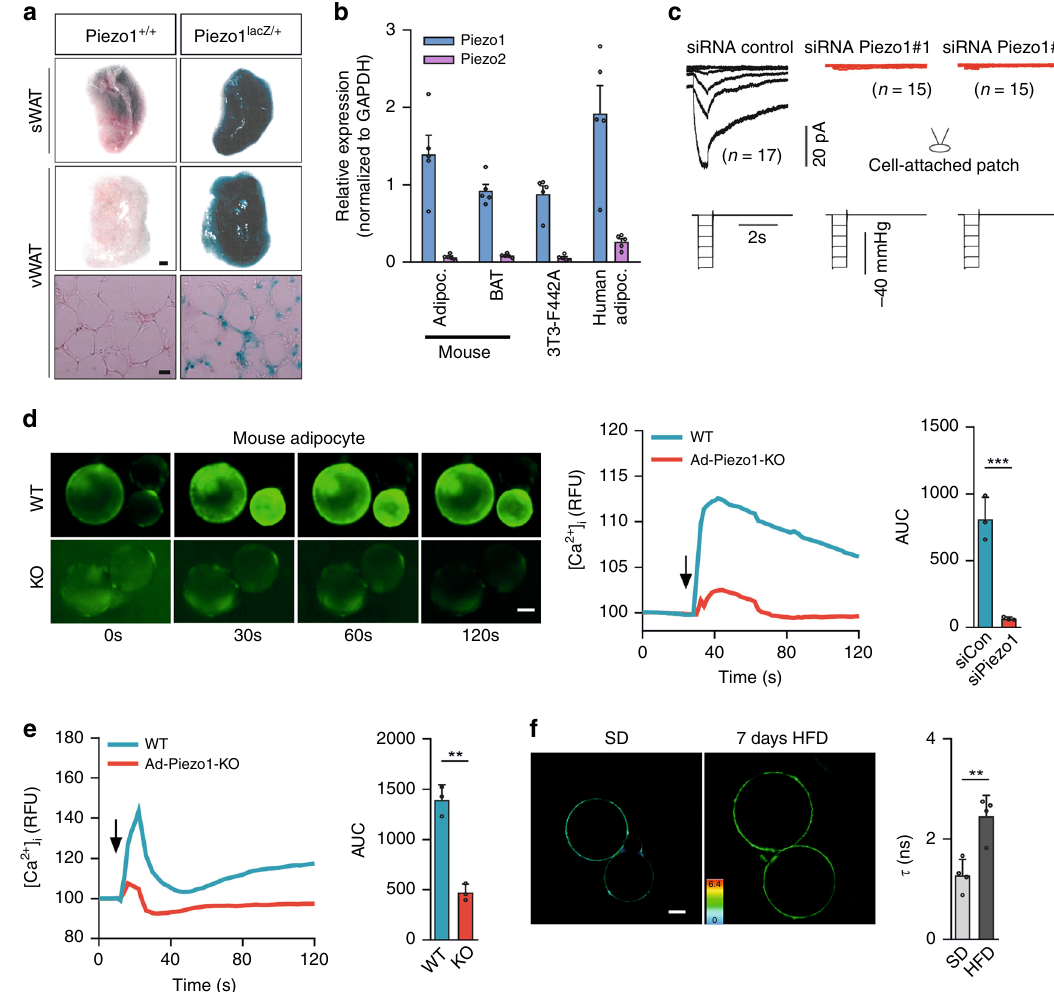
Fig. 1 Functional expression Piezo1 in adipocytes. a X-gal staining of inguinal sWAT and epididymal vWAT or of histological sections of vWAT prepared from wild-type mice (Piezo + / + ) or from Piezo1 lac Z / + mice, bar lengths: 1 mm (whole mount) and 20 μ m (histological section). Shown is a representative of three independent experiments. b Expression of mRNAs encoding Piezo1 or Piezo2 in murine and human vWAT adipocytes, brown adipose tissue (BAT) and in differentiated 3T3-F442A adipocytes ( n = 5 samples for each group). ( c ) Stretch-activated currents from differentiated 3T3-F442A were recorded in the cell-attached patch clamp con fi guration. The holding potential was − 80 mV and the membrane was stretched by pulses of negative pressure with a 10 mm Hg increment applied every 10 ss. Cells were transfected with control siRNAs or with siRNAs against Piezo1. d , e Fluo-4-loaded adipocytes prepared from vWAT of wild-type (WT) or Ad-Piezo1-KO mice were exposed to 10 µ M Yoda1 ( d ) or hypotonic buffer (210 mOsm/kg; e ), and [Ca 2 + ] i was determined as fl uorescence intensity (RFU, relative fl uorescence units); shown are representative images and experiments ( n = 3 mice per group (12 and 6 measurements per animal in d , e , respectively)). Arrows indicate the addition of Yoda1 or of hypotonic buffer. Bar diagrams show the area under the curve (AUC) of the Ca 2 + -transient. f Fluorescence lifetime τ 1 images of FliptR in visceral adipocytes from wild-type mice kept under normal show or fed a HFD for 7 days. Corresponding lifetime mean values are shown in the bar diagram. The color bar corresponds to lifetime in nanoseconds (ns). n = 4 mice per group (10 measurements per animal) ( f ). Bar lengths in d , f : 10 μ m. Shown are mean values ± s.e.m.; ** P ≤ 0.01; *** P ≤ 0.001 (two-tailed non-parametric Mann – Whitney U -test). Source data are provided as a Source data fi